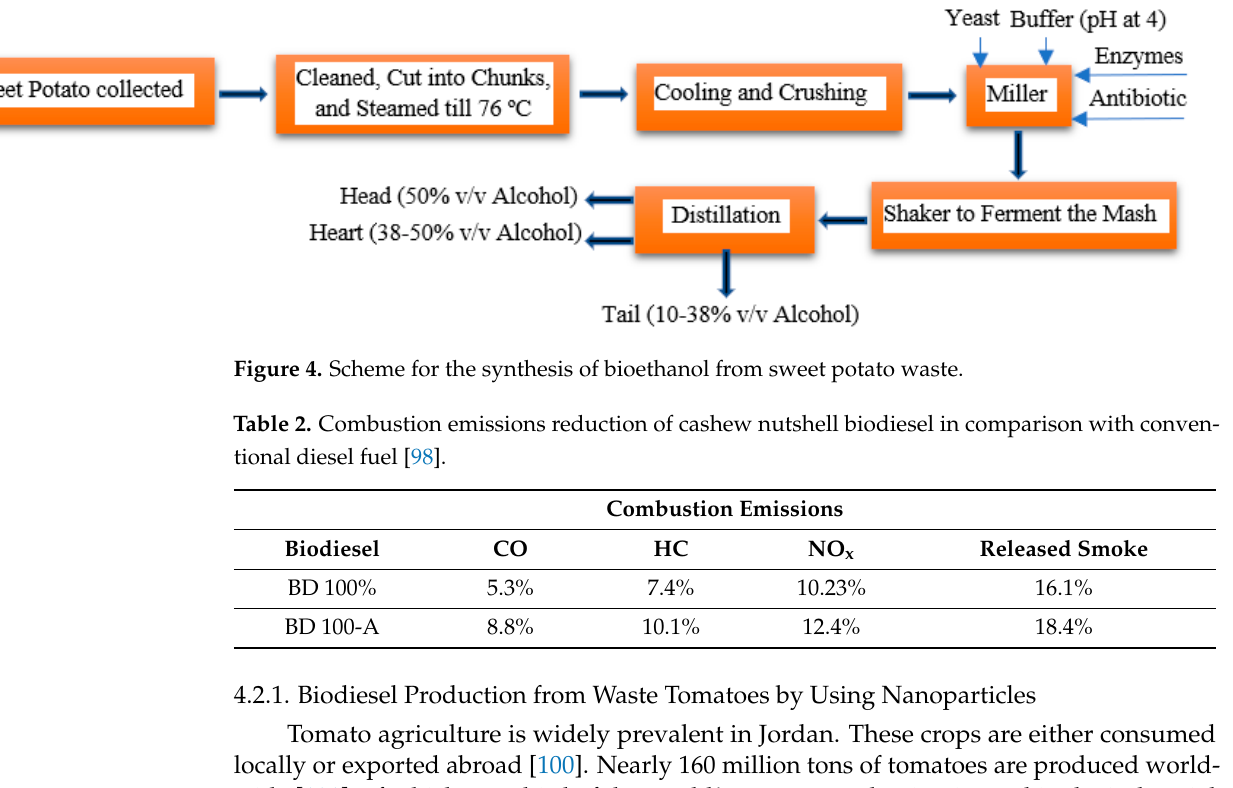
Figure 3. A circular bio-economy concept of a biorefinery for sweet potato crop waste.